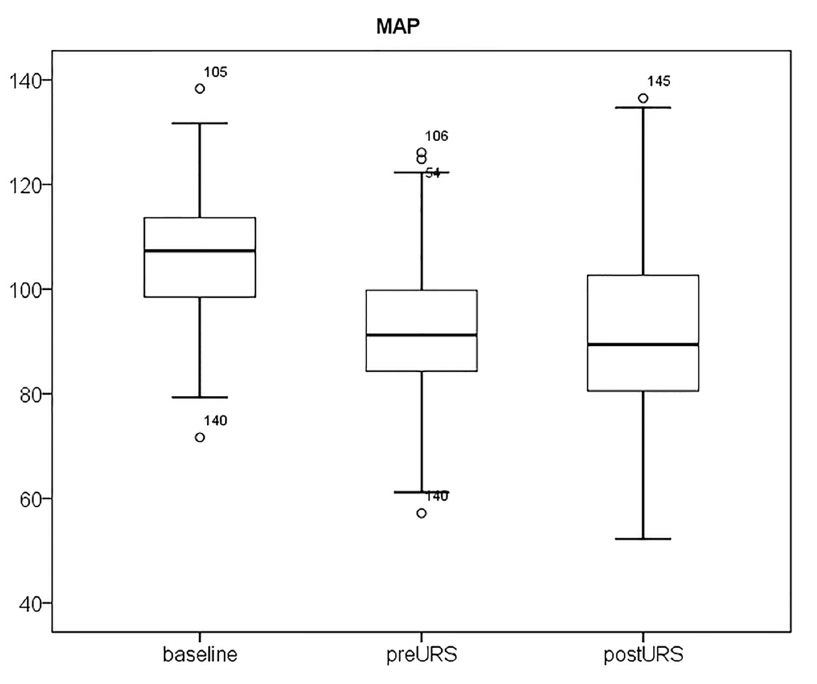
Fig. 2. Interquartile range (IQR) of mean arterial pressure (MAP) in patients with Grade I, II, and III hydronephrosis. The MAP decreased after induction of anesthesia, but there were no further changes during stone